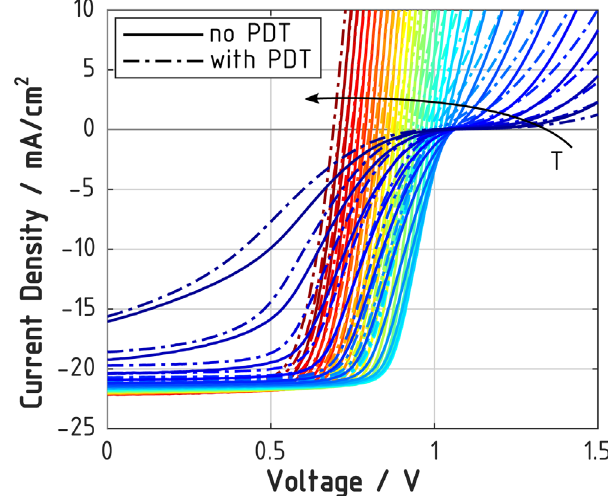
Fig. 2. Urbach energy for the investigated cell types, derived from EQE spectra of three samples per cell type.